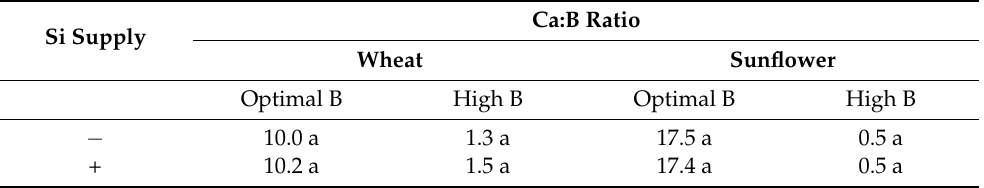
Table 4. Effect of Si supply (1.5 mM) on the relative proportion of Ca and B in the cell wall material from the youngest fully expanded leaves of wheat and